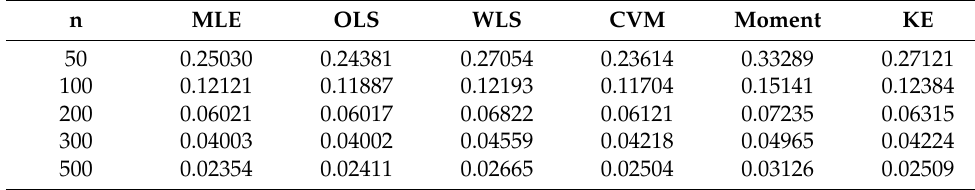
Table 1. MSEs under β =